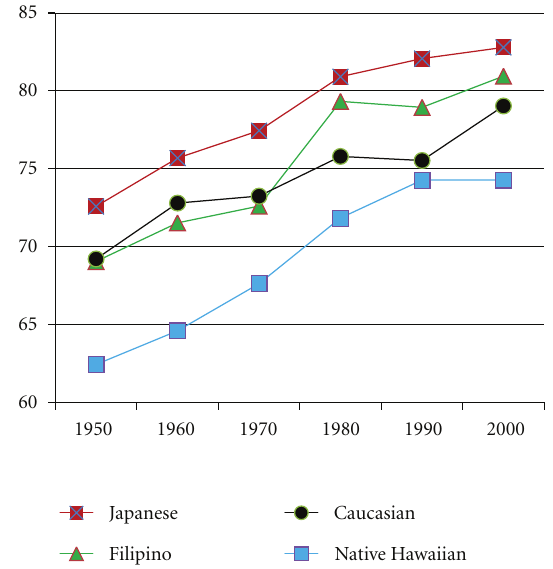
Figure 1: Life expectancy by ethnicity in Hawai‘i, 1950 through